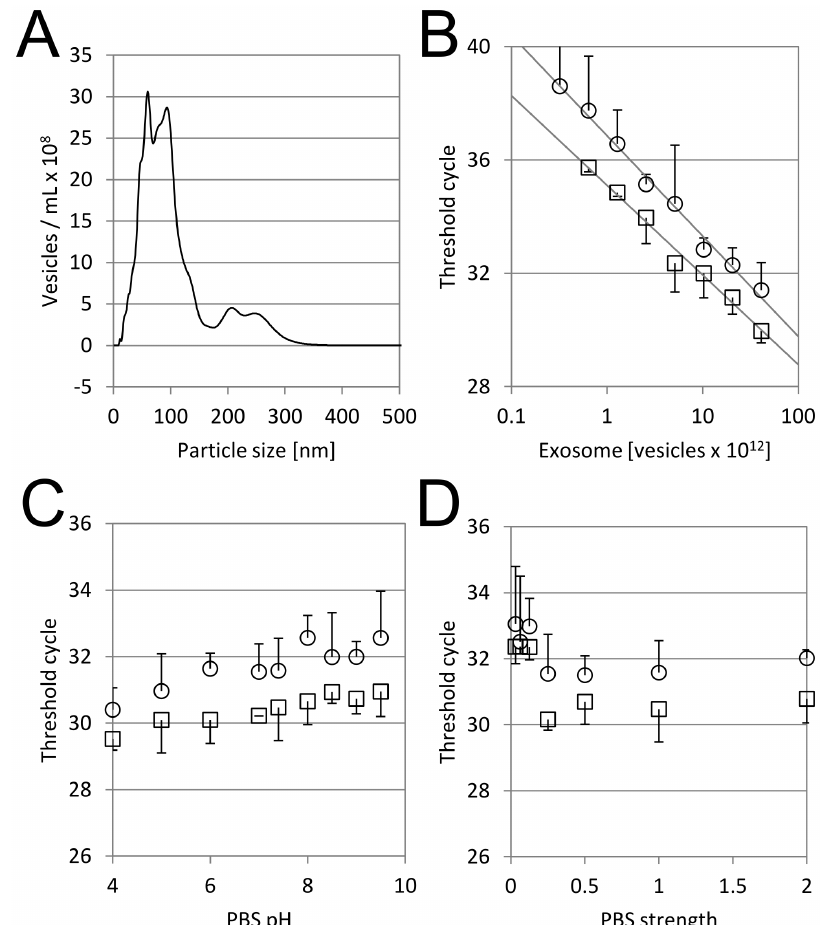
Figure 2. Performance Characterization using Isolated Urinary EMV. A. Urinary EMV were isolated from human urine using a differential centrifugation method and analyzed by nanoparticle tracking analysis as described in Materials and Methods. B–D. Urinary EMV was diluted in phosphate buffer saline (PBS) with different EMV concentrations (B), pH (C) or buffer strength (D), then applied to the filter material. ACTB ( # ) and GAPDH ( % ) were quantified in triplicate as described in Materials and Methods. Mean Ct values were plotted and error bars are standard deviations.